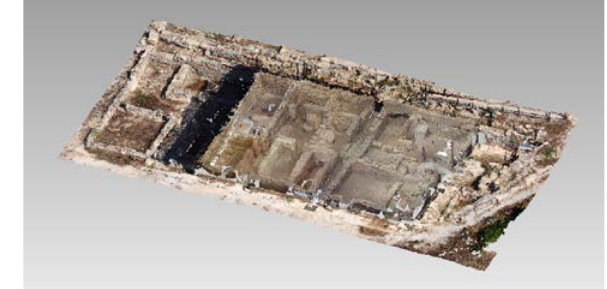
Figure 13. Integration of the RPAS and TLS 3D data in the same 3D model for a small part of the